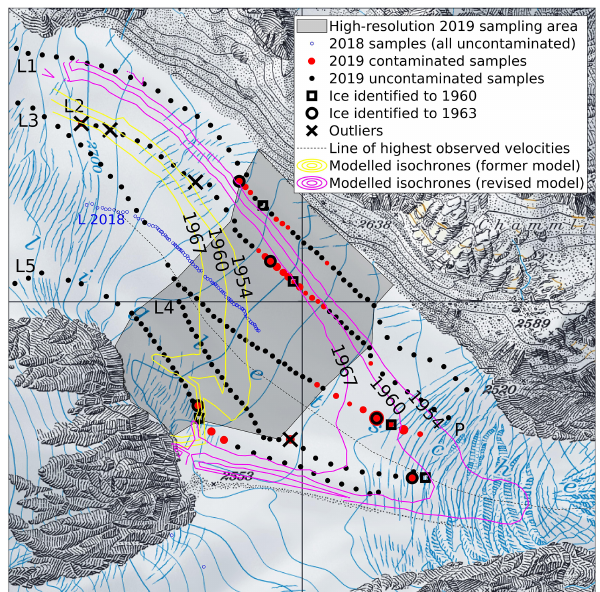
Figure 5. Topographic map of Gauligletscher with 1km grid spac- ing showing the 1954, 1960 and 1967 isochrones inferred from the original (yellow contour lines) and the revised best-guess (ma- genta contour lines) models, the five sampling lines (defined by “L1” to “L5”, and indicated by black dots), and the contaminated locations (where 239 Pu activities exceed 0.25mBqkg − 1 ) depicted by red dots, whose size corresponds with the 239 Pu activity. The squares and circles show the locations along each line identified as originating from 1960 and 1963 in Fig. 6, respectively. Crosses in- dicate measurement outliers not included for analysis. The shaded area corresponds to the region sampled in high resolution (i.e., ≈ 25m rather than ≈ 50m). The dashed line shows the line of maximal observed velocities along each lateral transect. The blue circles mark the line sampled in 2018, where no 239 Pu activities > 0 . 1mBqkg − 1 have been found. Reproduced by permission of swisstopo